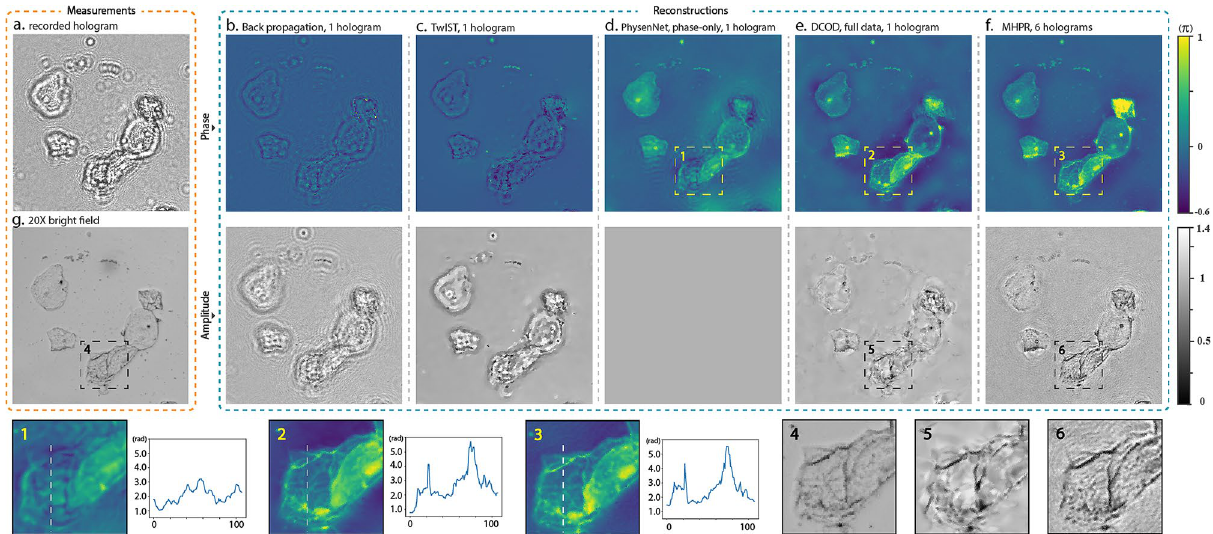
Figure 3. ( a ) The recorded hologram. ( b ) The backpropagated phase and amplitude images. ( c ) The images obtained by TwIST algorithm. ( d ) The reconstructed phase by PhysenNet assuming the object function only contains phase information. ( e ) The recovered phase and amplitude images by the proposed DCOD algorithm. ( f ) The reconstructed images obtained by multi-height phase recovery algorithm. ( g ) The bright-field microscopic image captured using a 20× objective lens